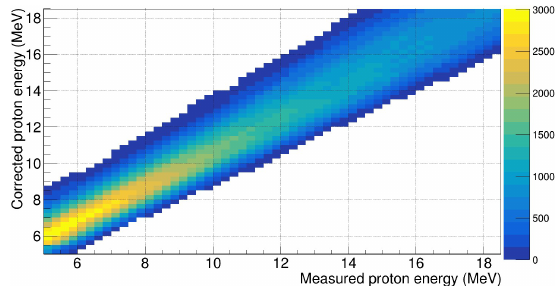
Figure 5. Geant4 simulated response function for the set-up with CH 2 target and